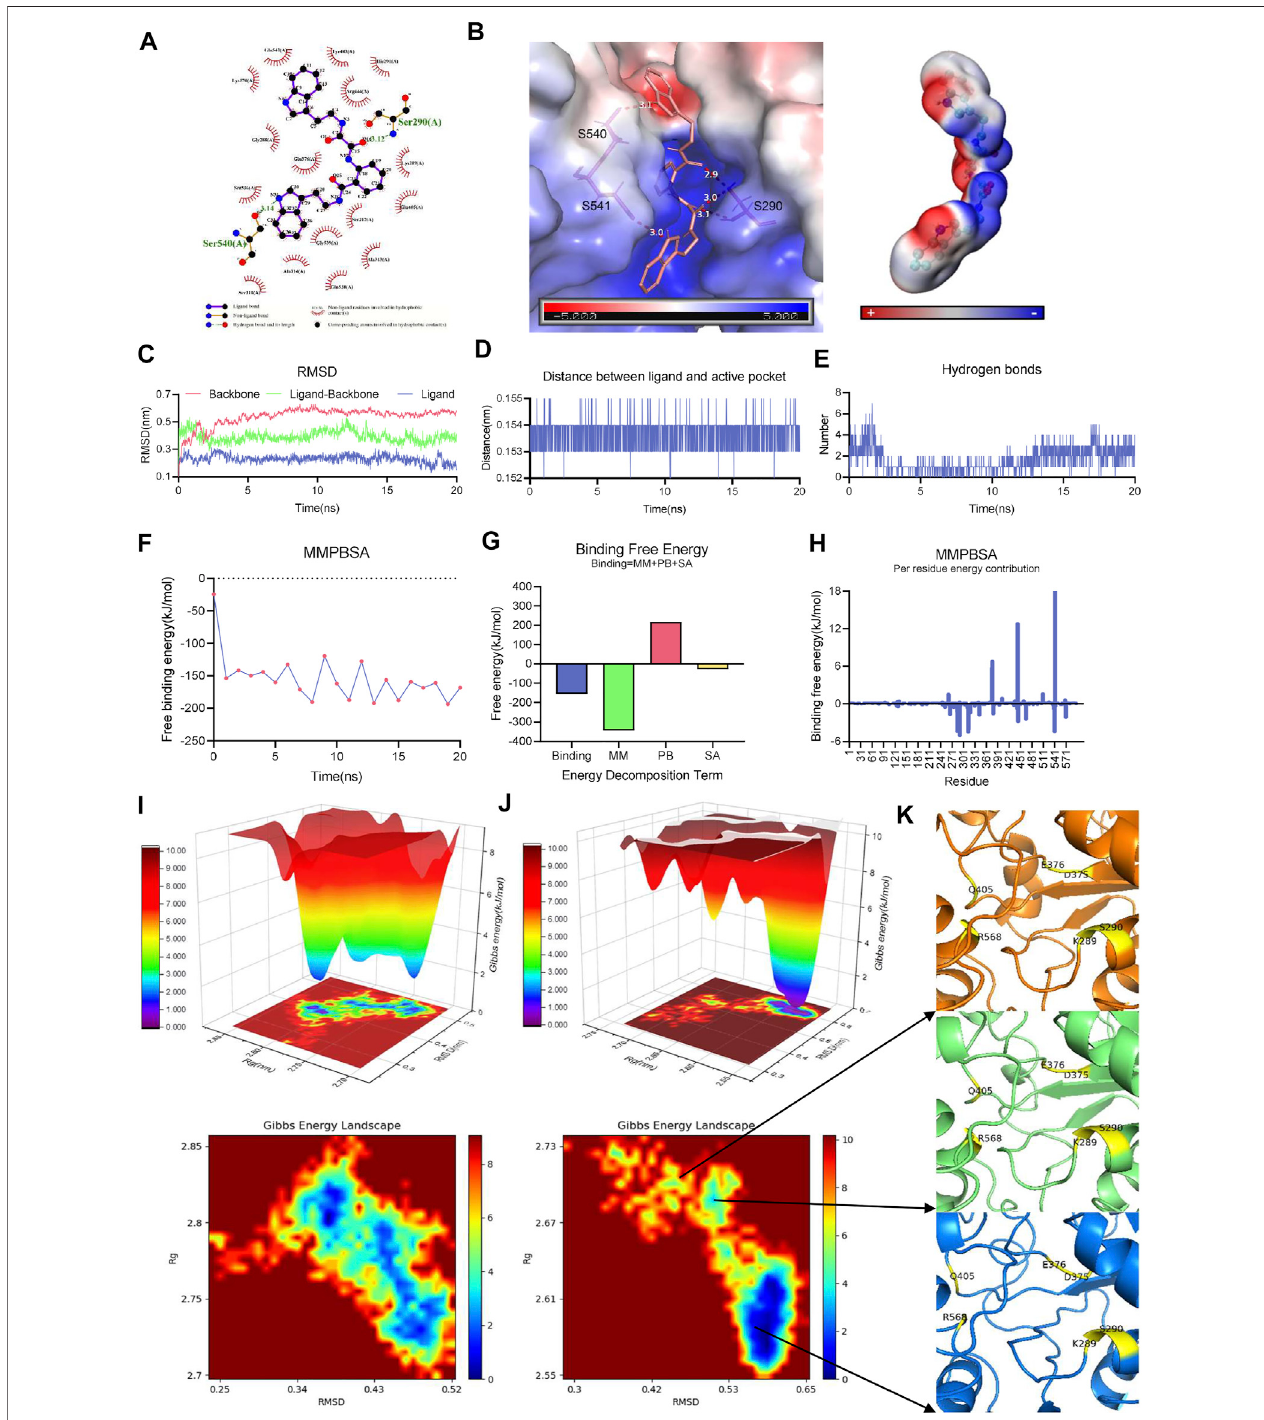
FIGURE3| ActivepocketofPEDVNTPaseistargeted byZINC12899676strongly,anditsconformationalchangeoccurs. (A) InteractionsbetweenPEDVNTPase andZINC12899676.IntermolecularhydrogenbondsareshownbygreendashedlineswithdistanceinÅ.Non-ligandresiduesinhydrophobiccontactsareshownbyred gear. (B) Left:H-bondbetweenPEDVNTPaseandZINC12899676analyzedbyPymolandtheelectrostaticpotentialsurfacerepresentationofPEDVNTPaseincomplex with ZINC12899676; right: electrostatic potential surface of ZINC12899676. (C) RMSD values of protein backbone, ligand-backbone, and ligand over the simulationtime. (D) DistancebetweentheligandandactivepocketofPEDVNTPaseoverthesimulationtime. (E) NumberofH-bondsinvolvedintheinteractionbetween theproteinandcompoundduringtheMDsimulation. (F) FreebindingenergyofPEDVNTPaseandZINC12899676calculatedbyMM-PBSA. (G)